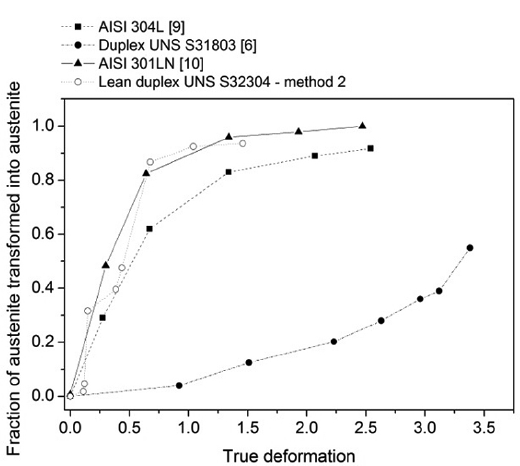
Figure 9. Comparison of austenite fraction transformed into martensite in different steels.